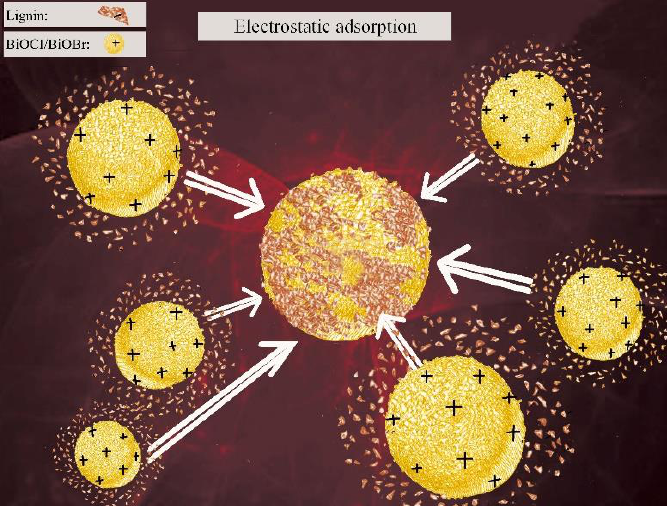
Figure 4. Schematic diagram of the electrostatic adsorption between BiOCl/BiOBr and lignin. Table 1. Initial pH values and zeta potentials of adjusted